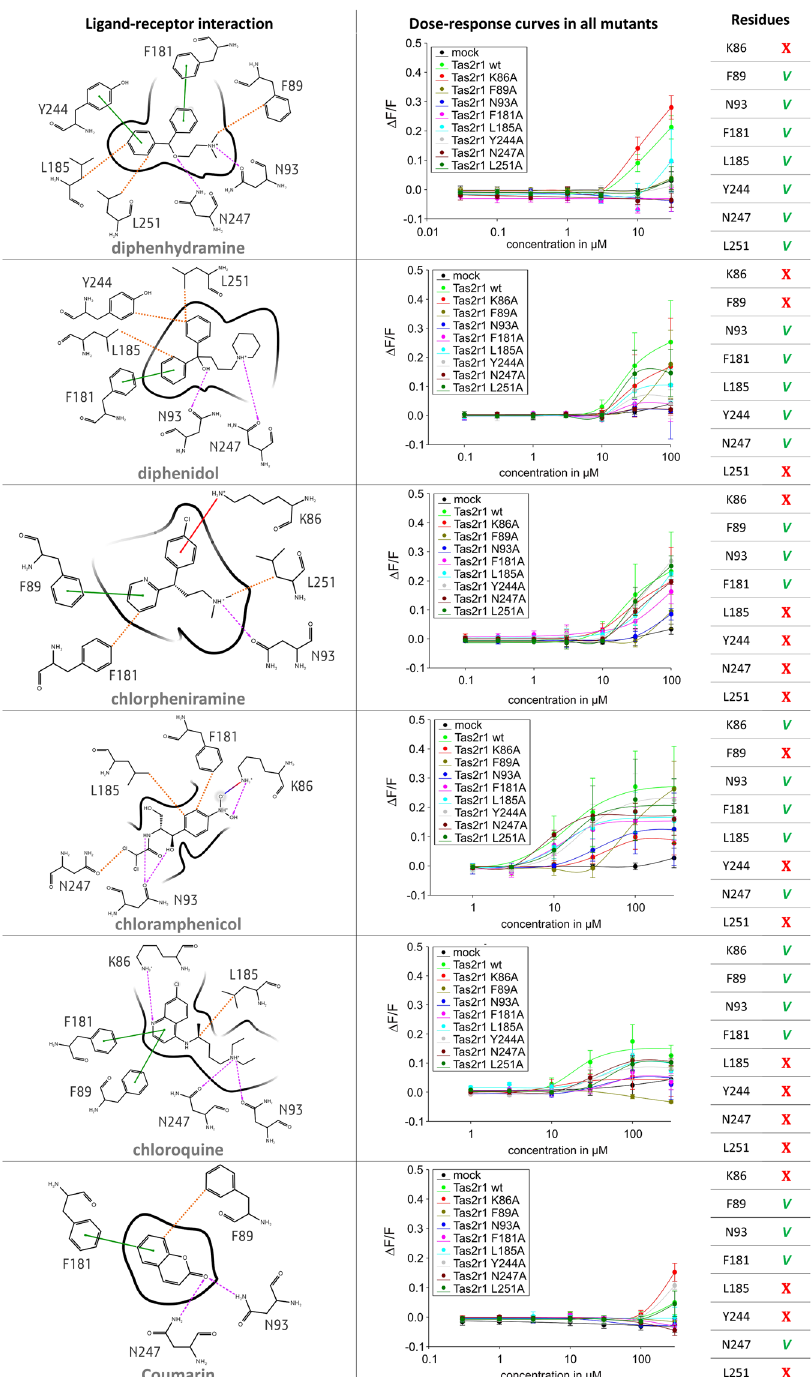
Figure 4. 2D representation of predicted binding modes, mutagenesis data and residues involved in the binding of ggTas2r1 agonists. H-bond interactions are shown as magenta dashed arrows, salt bridges as blue- red lines, π−π interactions as green lines, cation −π interactions as red lines and hydrophobic interactions are represented as the distances between the closest heavy atoms of the ligand and the residue as orange dotted lines. Dose-response relations for the specified compounds in cells expressing point-mutated and native ggTas2r1 constructs: the y-axis shows the relative fluorescence changes ( Δ F/F), and the x-axis the ligand concentration in μ M. Green checks indicate residues involved in the binding, red crosses residues that are not involved in the binding, as deduced from experimental data: we consider “not involved in the binding” those residues that when mutated to alanine show a curve equal (or higher) than that of the wild-type, and “involved” the residues that mutated to alanine have a decreased response (with a change of at least ~0.1 Δ